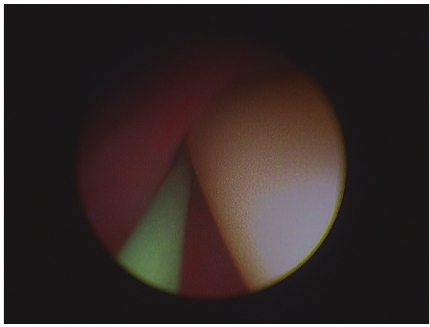
Figure 2: Guide wire placed alongside Foley catheter to facilitate passage of flexible ureteroscope.